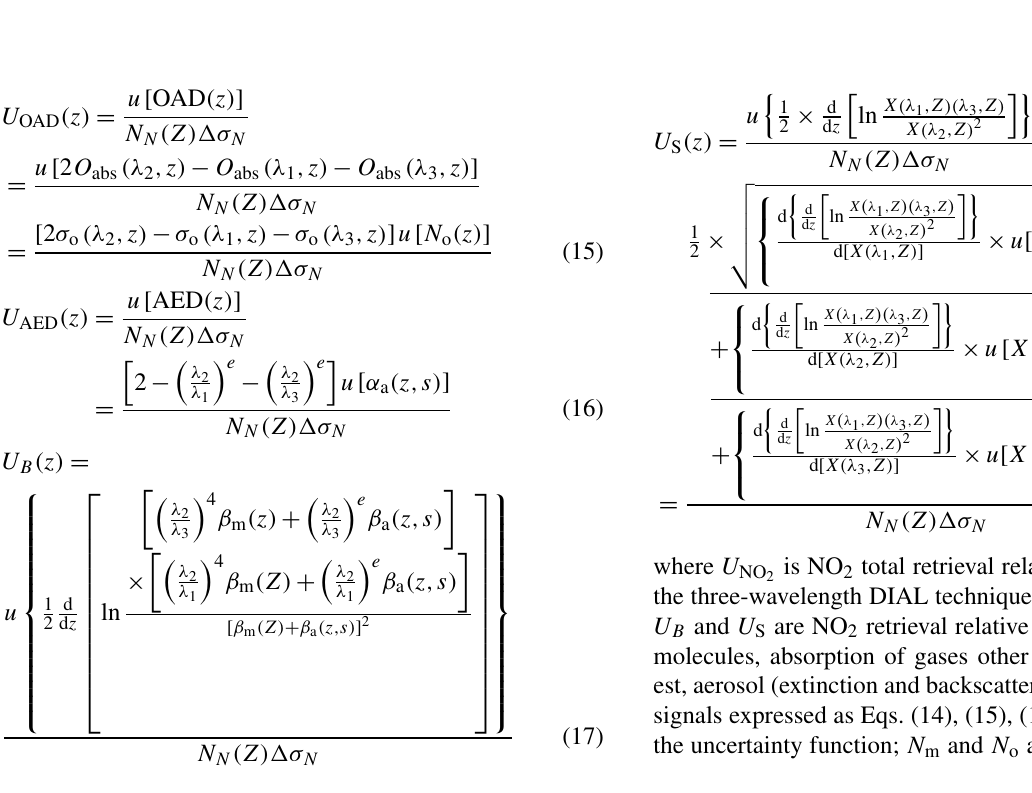
Figure 8. NO 2 number density relative uncertainty owing to aerosol extinction (a) and backscatter (b) with e =